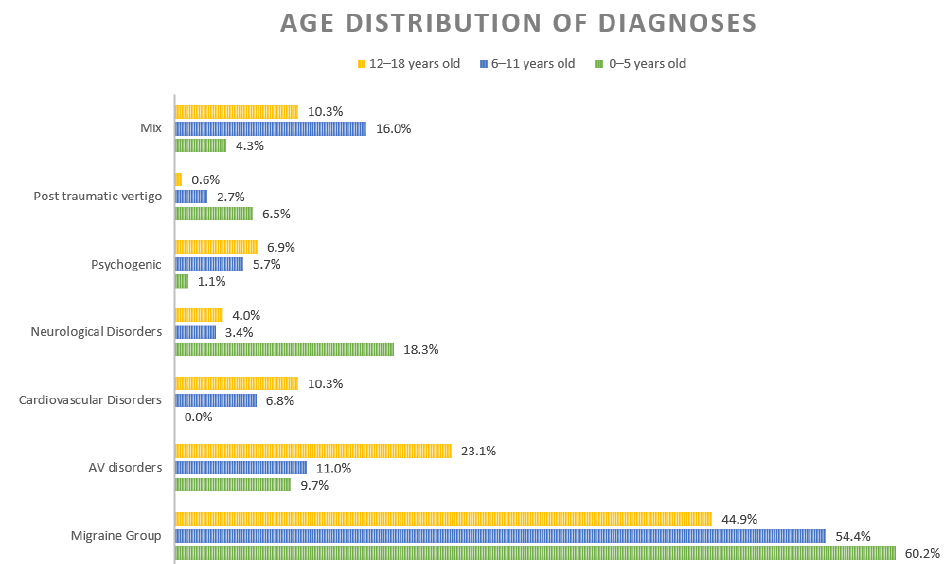
Figure 3. Distribution of different diagnoses according to age. “Mix” refers to a cumulative % of sporadic diagnoses and non-otherwise specified diagnoses.